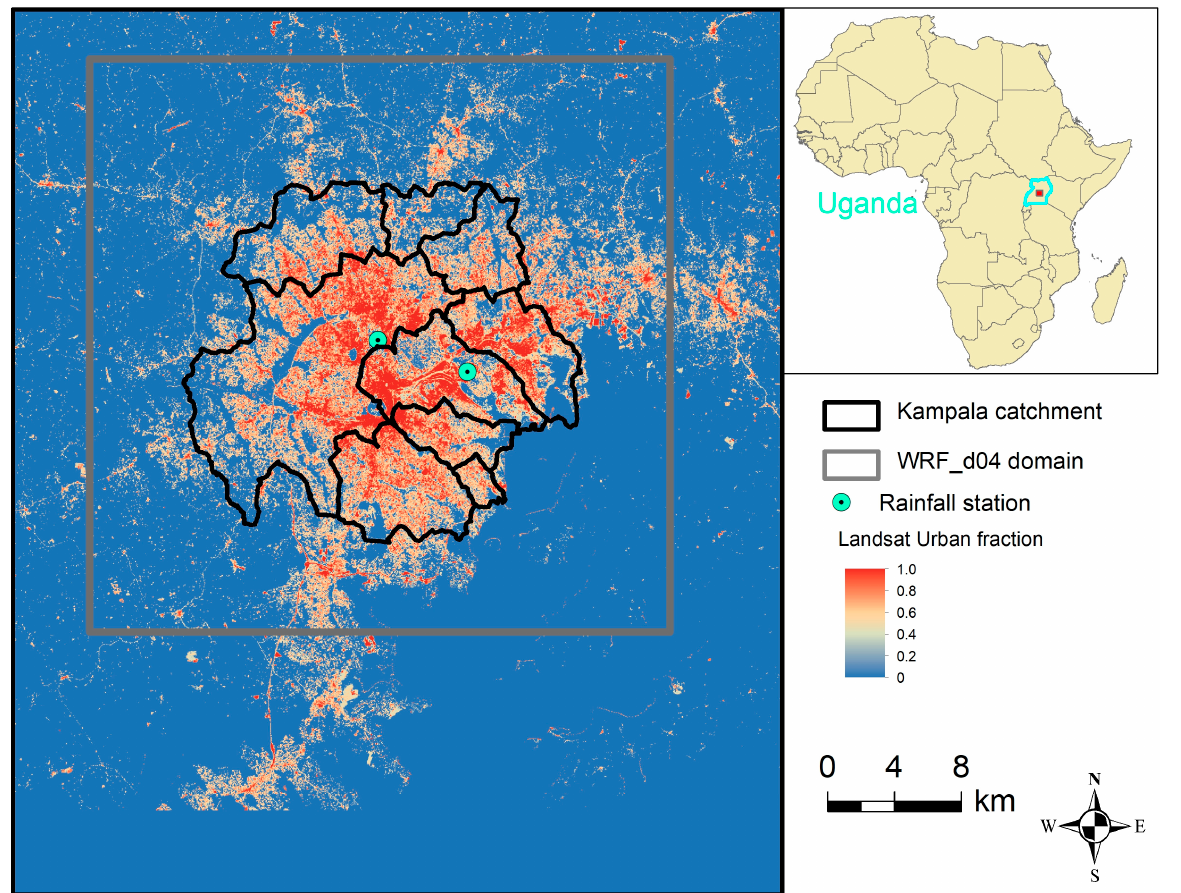
Figure 1. Study area: Kampala catchment boundary represented by dark line polygon; Gray line rectangle indicates WRF d04 domain boundary and map of urban fraction in Kampala as derived from the Landsat image [27].